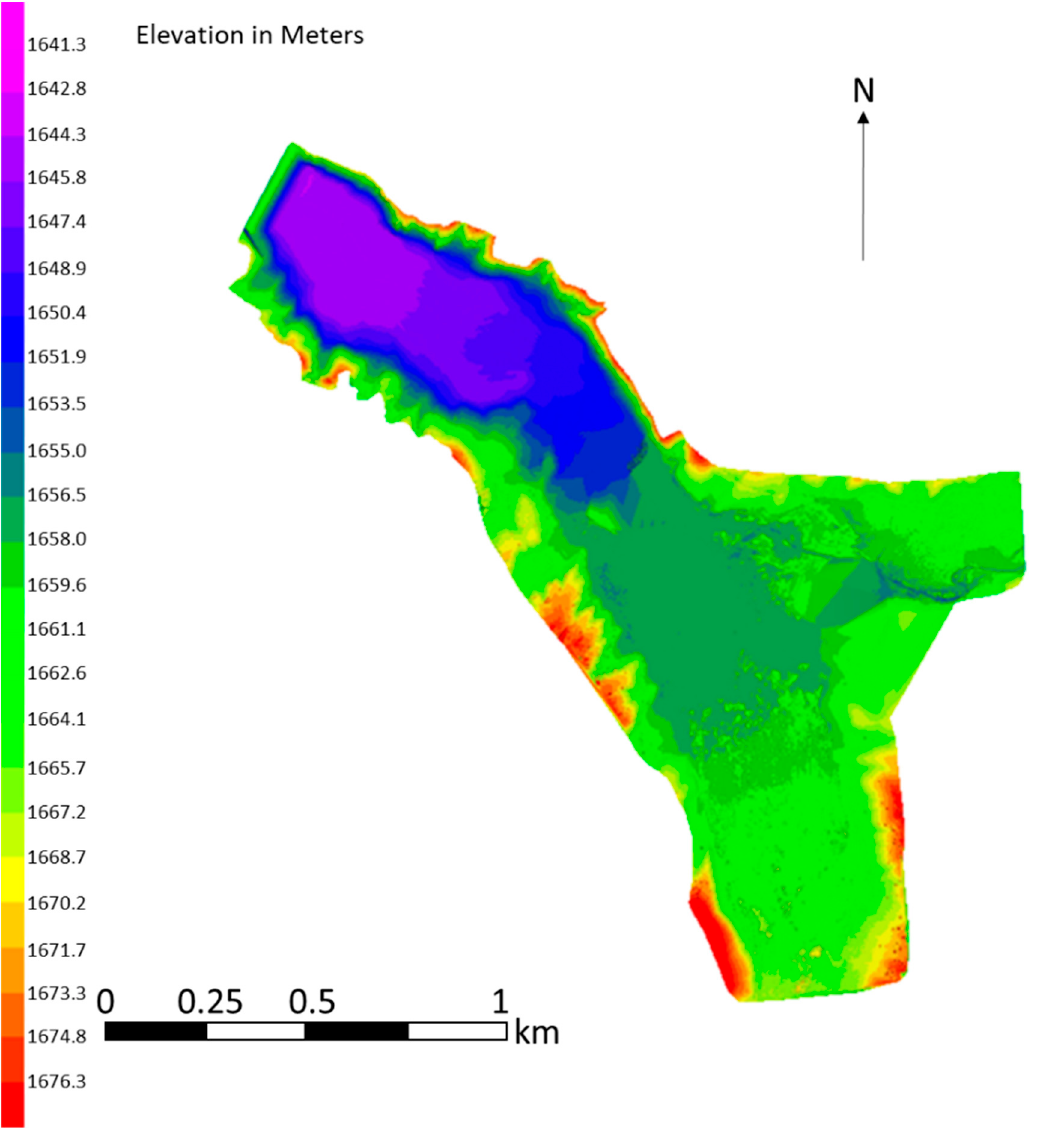
Figure 14. Digital terrain model of Newcastle Reservoir produced using the data shown in Figure 13. The gap between the sonar and sUAV models shown in Figure 13 was filled by interpolating between the two datasets. Figure 14 shows the merged complete Digital Terrain Model (DTM) produced. Figure 14 shows the final model in Arc GIS Pro, which was used to interpolate the data, while the alignment (Figure 13) was performed in HYPACK. Arc GIS Pro could have been used for both tasks. Figure 15 shows the merged Starvation Reservoir model generated using the same methods. Note that the horizontal extent of Figure 14 is only about 1 km, while that of Figure 15 is approximately 12 km, a significant difference in